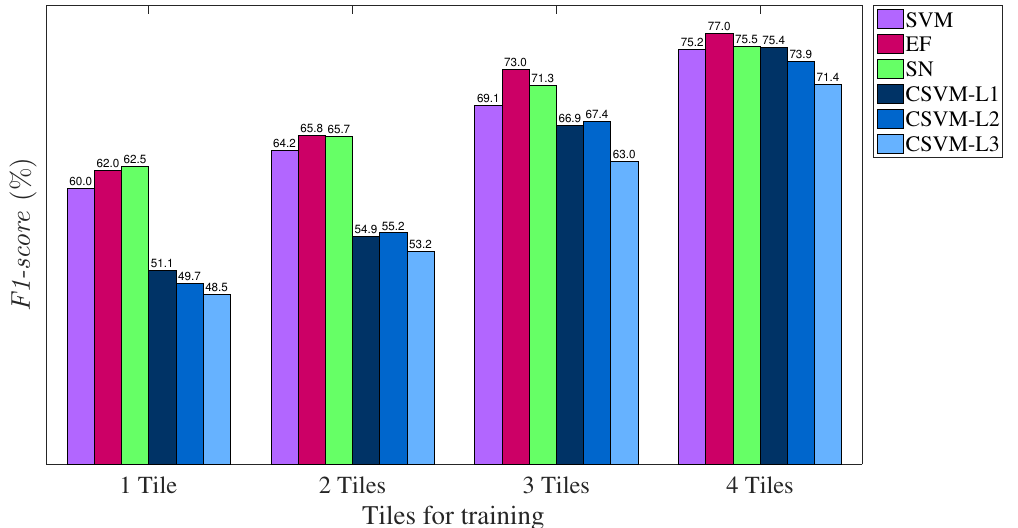
Figure 17. F1-score of Cerrado Biome obtained from SVM, EF, SN, and CSVM using one, two, three, and four training tiles.